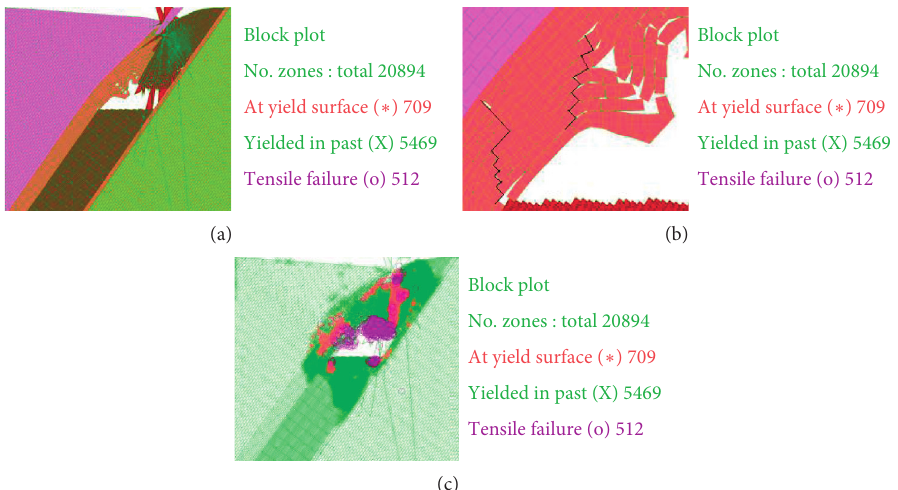
Figure 11: Overburden movement rule. (a) Diagram of overburden movement. (b) Step-like failure pattern. (c) The plastic zone